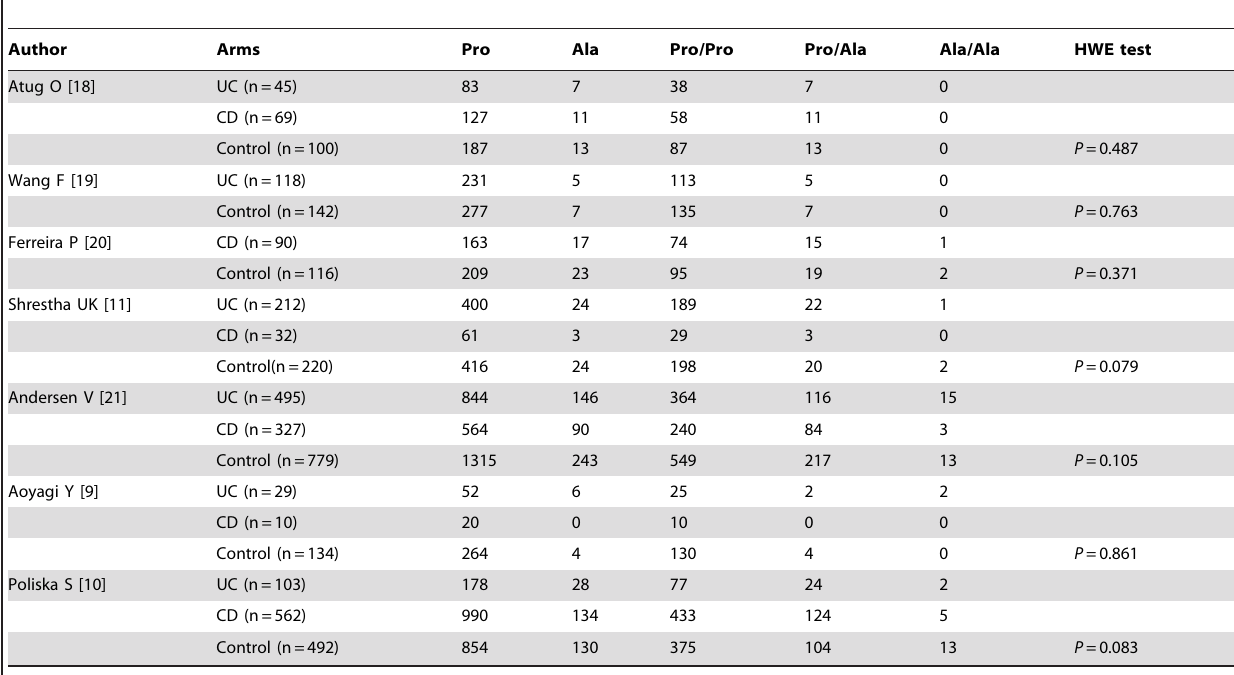
Table 2. Allele and genotype frequencies of the arms of included studies evaluating the association between the PPAR c Pro12Ala mutation and the presence of